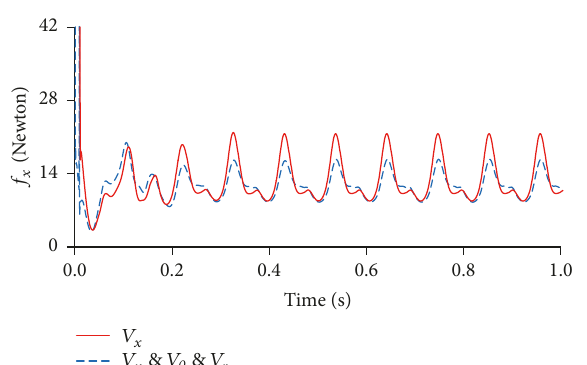
Figure 22: Time histories of the axial force of one blade under ship’s wake with/without cross flows.